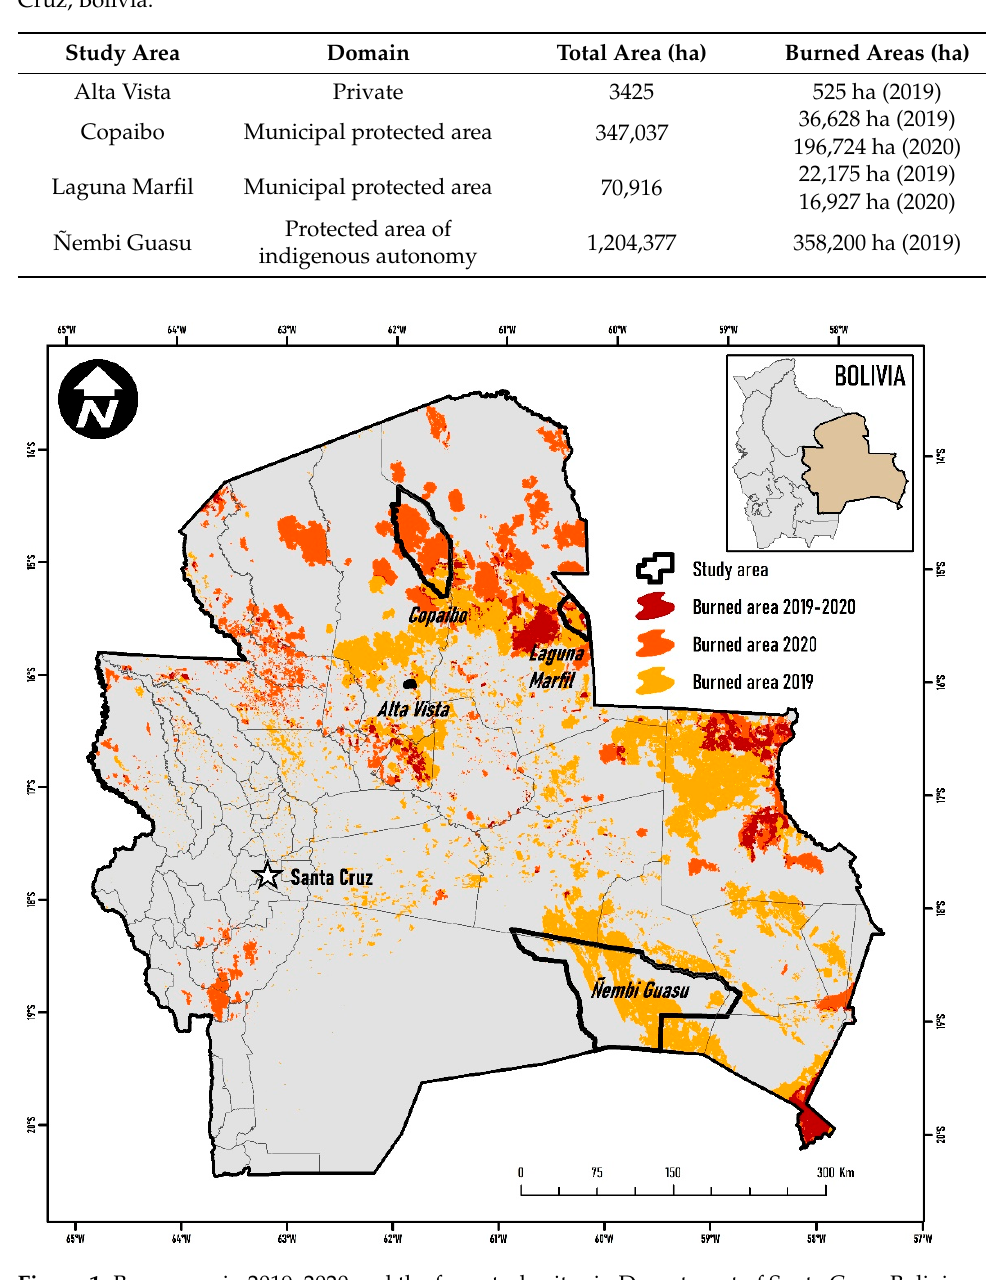
Figure 1. Burn scars in 2019–2020 and the four study sites in Department of Santa Cruz, Bolivia.